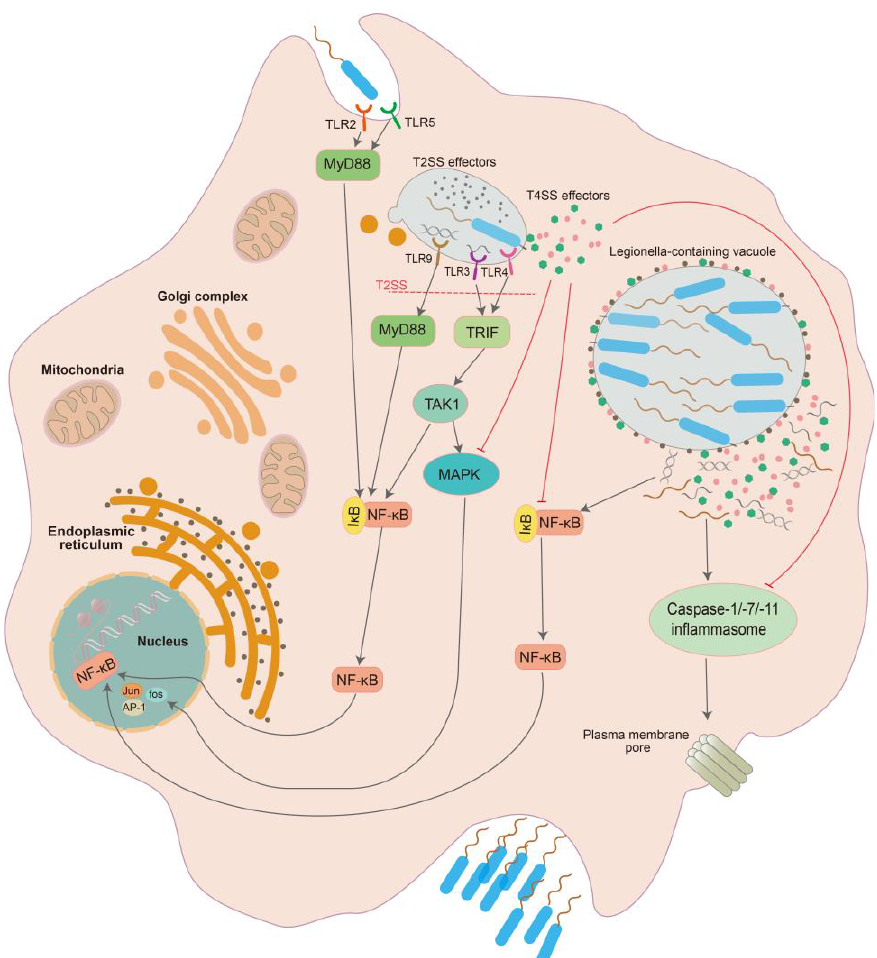
Figure 1. Legionella modulates macrophage immunity throughout its life cycle. The schematic shows that Legionella suppresses immune activation on macrophages in the early stages of infection and increases it in the late stage to ensure host cell survival and bacterial replication. The black arrow indicates the activation, and the red path indicates the inhibition of the signaling pathway. Once macrophages recognize the LPS and flagellin of Legionella bacteria via the pattern recognition receptors TLR2 and TLR5, respectively, immune signaling pathways are instantly activated. T2SS effectors produced by the internalized Legionella impair the TLR9-DNA, TLR3-RNA, and TLR4-LPS stimulation of the NF- κ B signaling pathway after ingestion, whereas T4SS effectors interfere with the inflammasome activation pathway and then prevent cell pyroptosis. At later phases of infection, decreased LCV membrane integrity leads to increased nucleic acid and flagellin leaks, which collaborate with specific T4SS effectors to continually aggressively stimulate the NF- κ B signaling pathway, and considerably drive transcription of inflammatory factors.